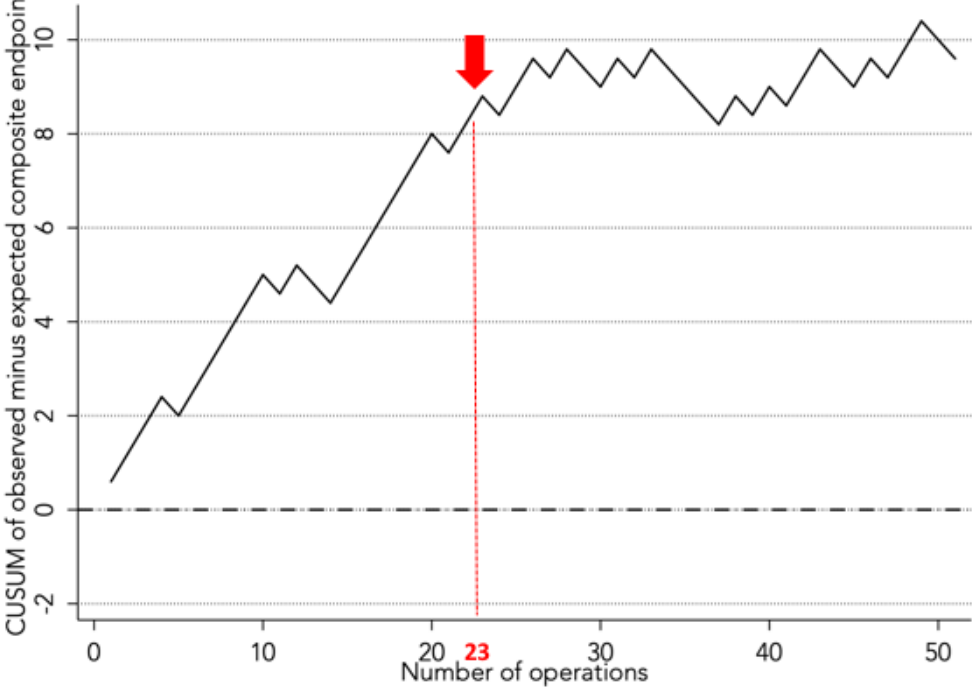
Fig. 3 - CUSUM analysis of outcomes between observed and expected rates of reaching the composite endpoint (i.e., 90-day mortality, neurological event, reoperation for bleeding, need for a temporary right ventricular assist device, or pump thrombosis). The association between the quality of outcomes and the